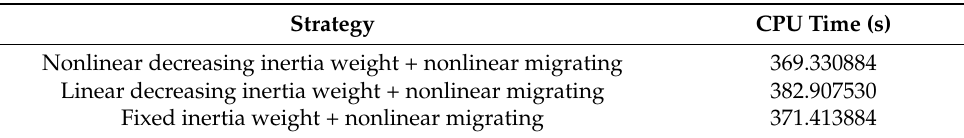
Table 6. CPU times of different inertia weight strategies.